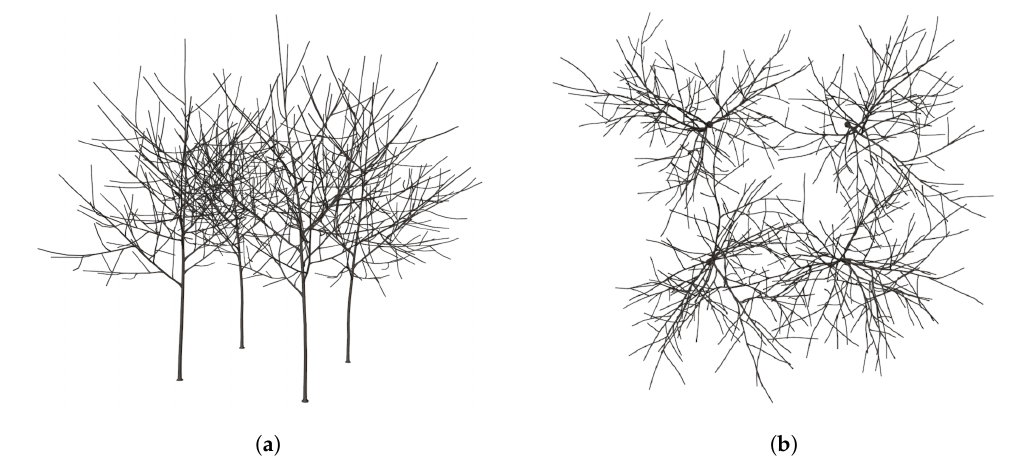
Figure 15. Group of 2 trees growing at 2 m distance. ( a ) Side view of 2 trees growing at 2 m distance; ( b ) Top view of 2 trees growing at 2 m distance.